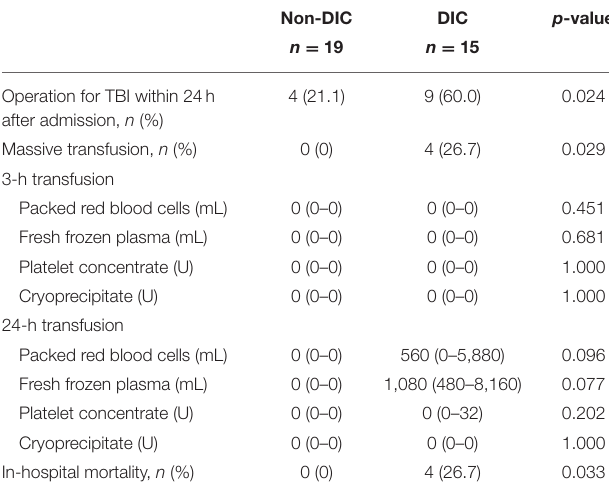
TABLE 5 | Requirement for transfusion and emergency surgery, and in-hospital mortality in isolated traumatic brain injury patients with and without disseminated intravascular